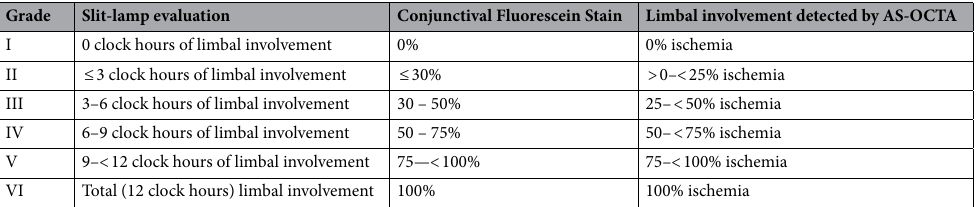
Table 1. Proposed classification of chemical ocular injury including anterior segment optical coherence tomography (AS-OCTA) detection of limbal